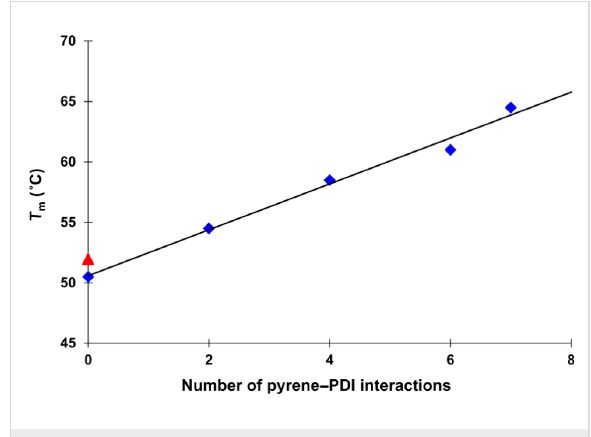
Figure 2: A plot of melting temperature ( T m ) versus the number of pyrene–PDI interactions for duplexes 1*2 to 1*6 (from left to right) presented in Table 1. The T m was recorded at 260 nm; R 2 = 0.987. The red triangle represents the T m of the control hybrid 7 * 6 .